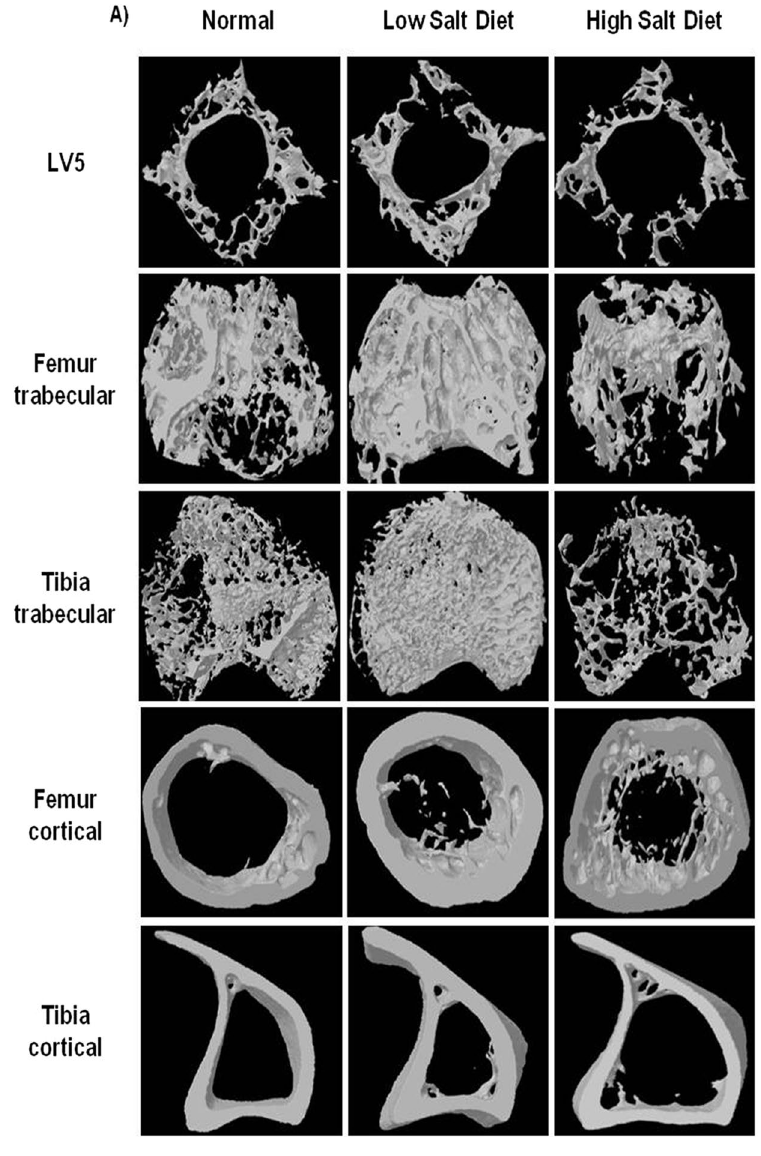
Figure 2. High dietary salt intake reduces trabecular and cortical bone microarchitecture. ( A ) 3-D μ CT reconstructions of LV5, femur trabecular, tibia trabecular, femur cortical and tibia cortical of normal, low salt diet (LSD) and high salt diet groups (HSD). The above images are representative of one experiment and similar results were obtained in three different experiments with n = 10